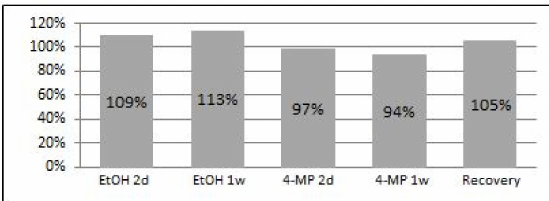
Figure 5. Methylation analysis of sub-telomeric regions of chromosome 10 in hFF-IM cells. Cells were treated with both EtOH and 4-MP for two days and one week, and additionally with the recovery treatment. Analysis of methylation status was performed by pyrosequencing. Percentages are relative to untreated